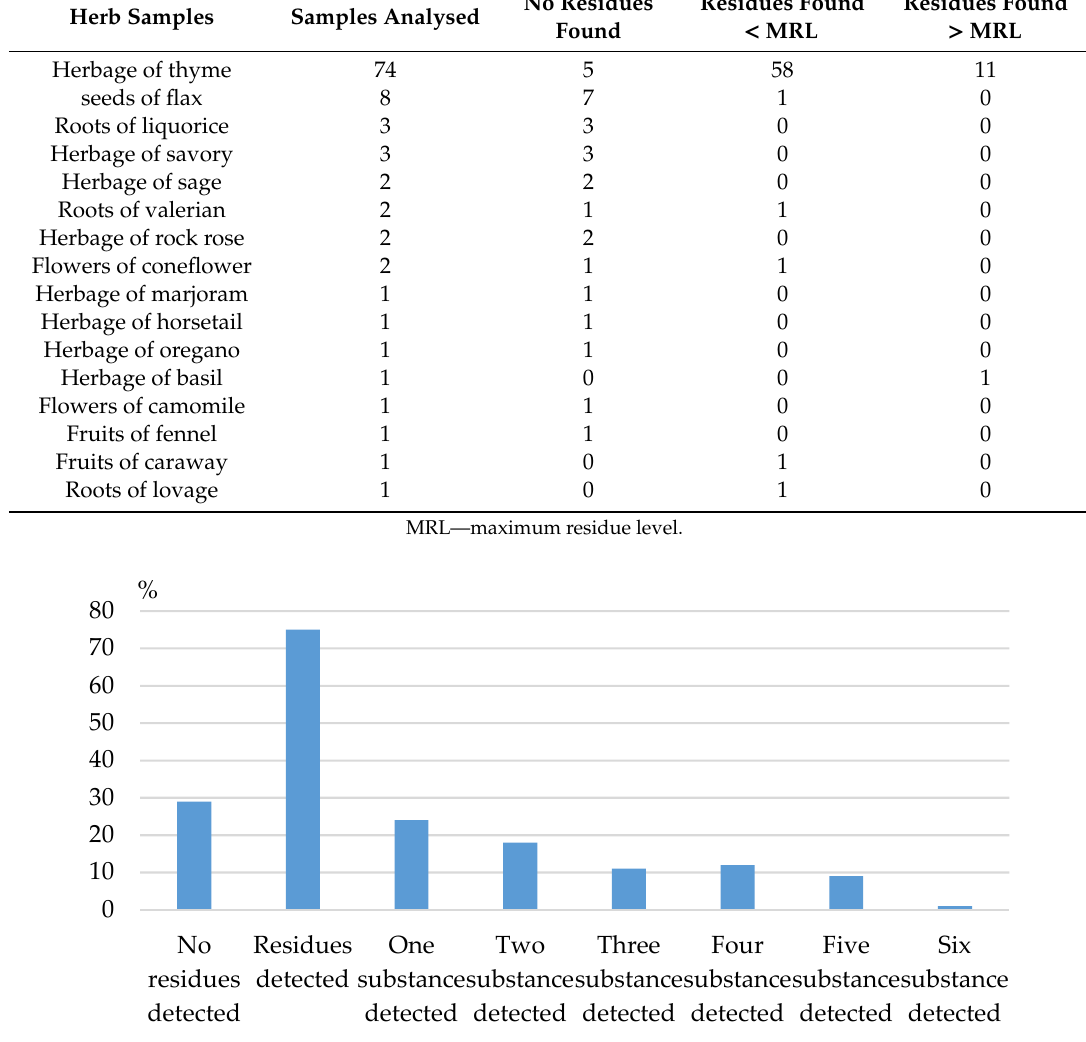
Table 1. Number of samples with and without detected pesticides residues for each analysed herb sample. Herb Samples